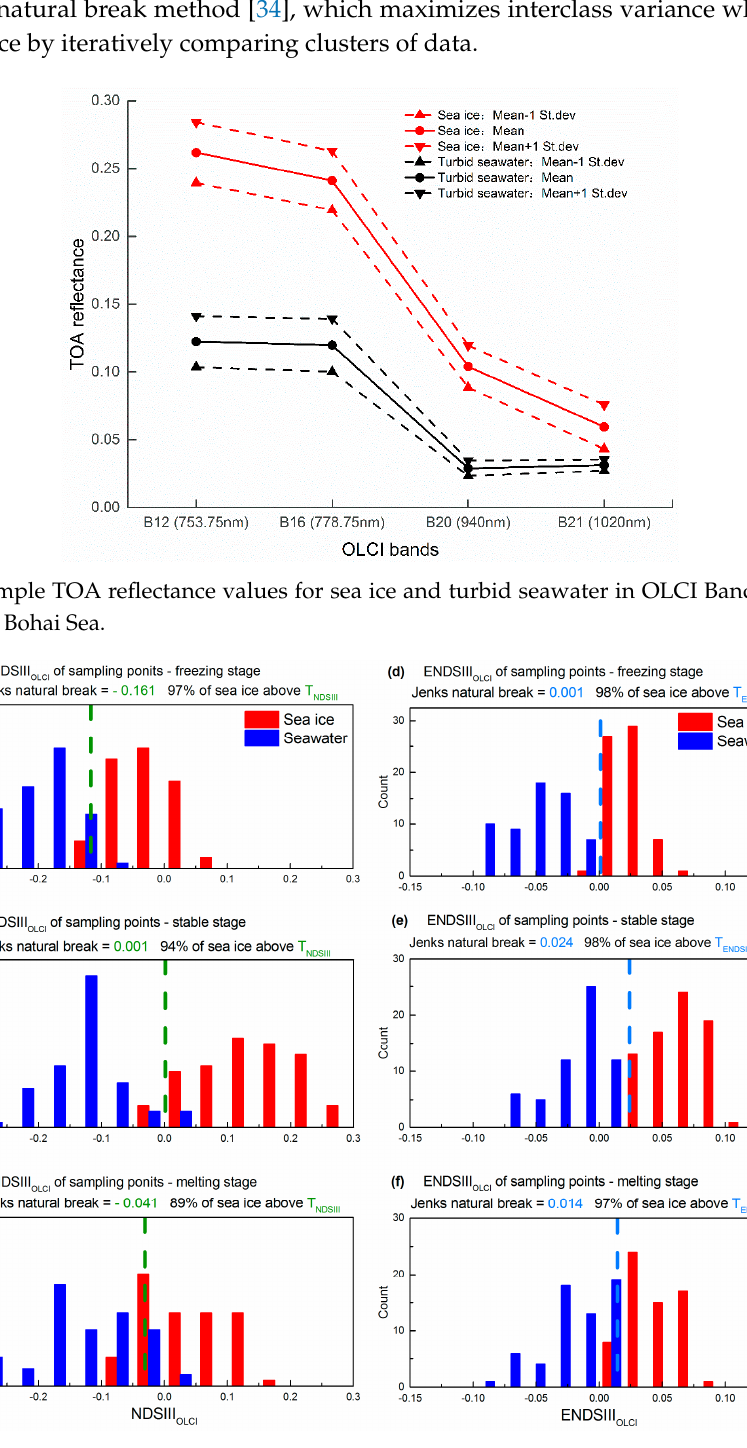
Figure 4. The histogram distributions of sampling points for the three sea ice development stages (freezing, stable and melting stages) with NDSIII OLCI ( a–c ) and ENDSIII OLCI ( d–f ). The T NDSIII and T ENDSIII threshold values (dashed vertical lines) were determined for sea ice separation by the Jenks natural break method.